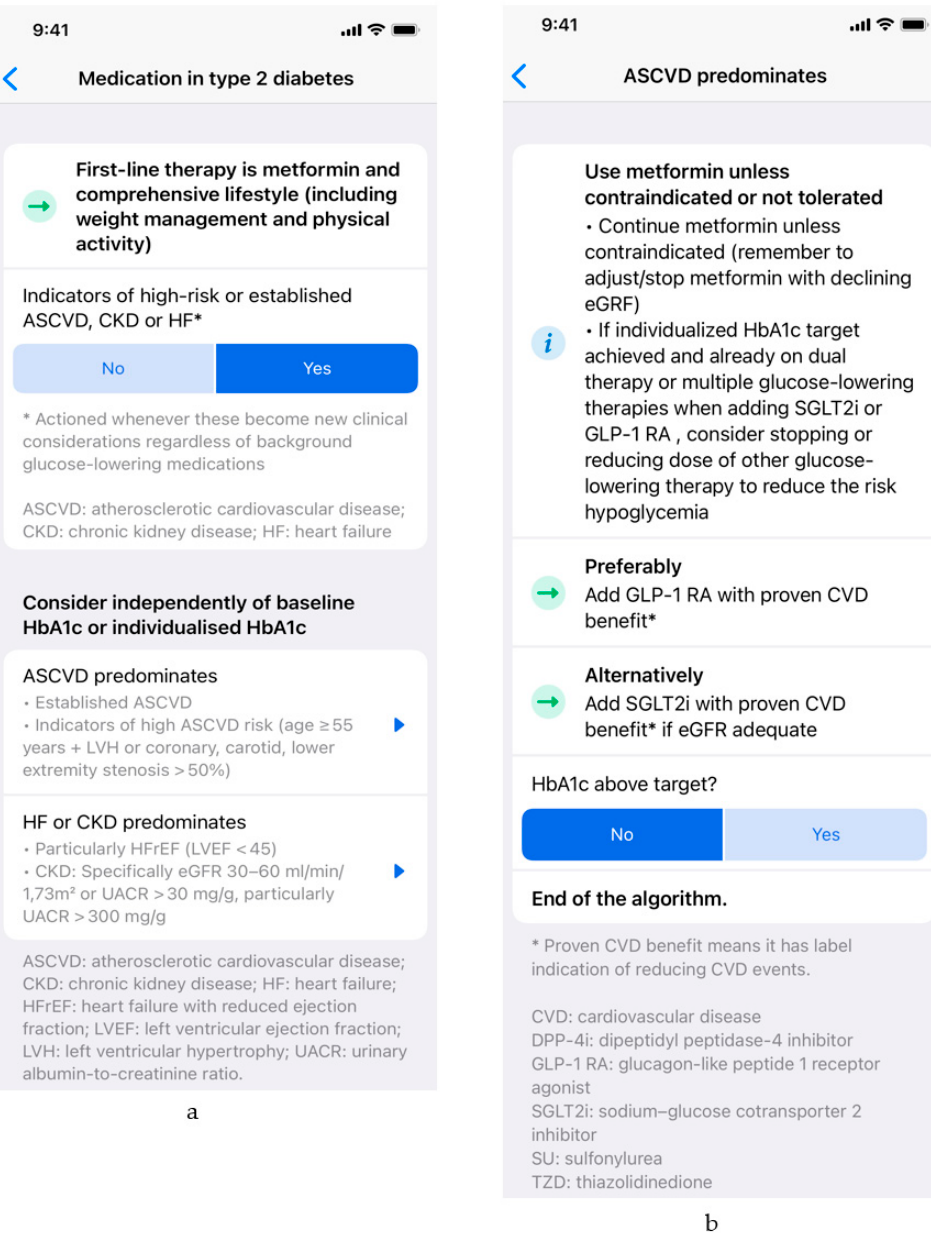
Figure 2. An illustrative usage scenario: ( a ) first-line therapy is suggested to the user, along with inquiry that enables comorbidity-based treatment individualization (predominating atherosclerotic cardiovascular disease, predominating heart failure, or chronic kidney disease); ( b ) specific recom- mendations for patients with predominating atherosclerotic cardiovascular disease are presented to the user. HbA1c: hemoglobin A1C (glycated hemoglobin); eGFR: estimated glomerular filtration rate